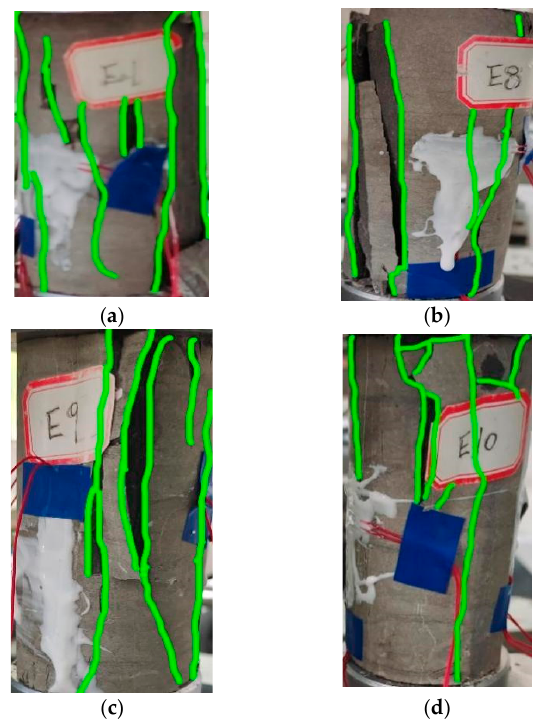
Figure 6. Failure diagram of limestone samples with di ff erent water content rates. ( a ) Water con- tent rate 0%, ( b ) water content rate 0.07%, ( c ) water content rate 0.1%, ( d ) water content rate 0.27%.